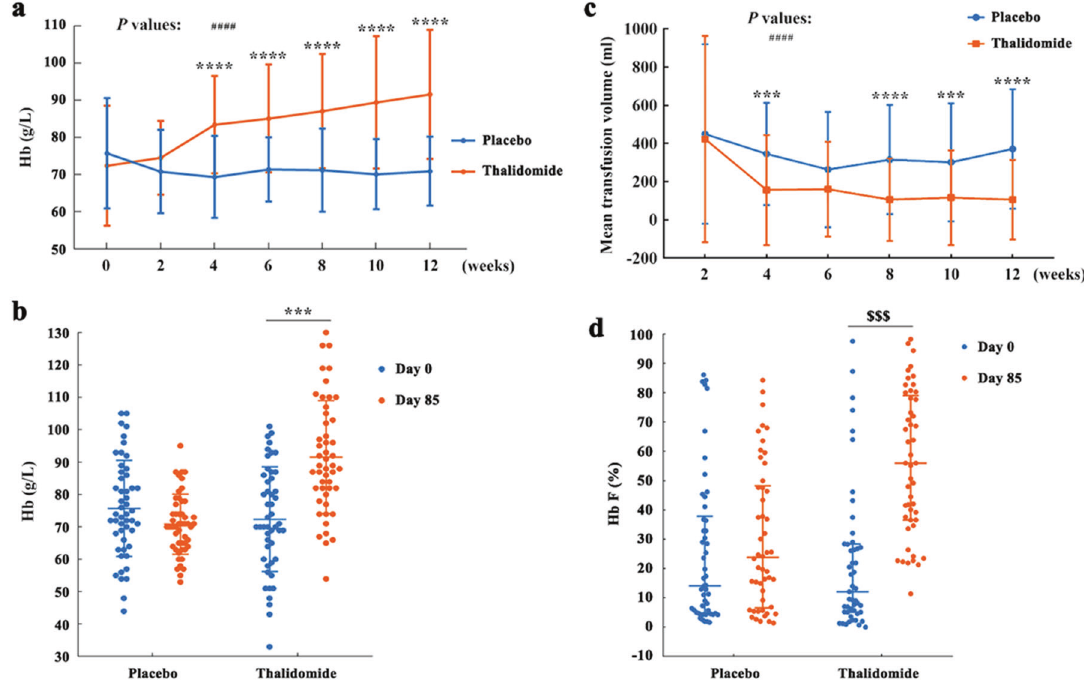
Fig. 2 Changes in Hb, transfusion volume, and Hb F in patients upon placebo or thalidomide treatment. The levels of Hb ( a , b ) and transfusion volume ( c ) were expressed as mean ± standard deviation (SD), and P values determined by Student ’ s t test (*) and mixed-effects regression analyses (#) were provided. *** P < 0.001, **** P < 0.0001; #### P < 0.0001. The percentages of Hb F ( d ) were expressed as median (interquartile range), and P value was determined by Mann – Whitney U test. $$$ P < 0.001 Table 2. Genotype and change in Hb. Data are expressed as median (range) Genotype Table 3. Hb levels of the patients treated with thalidomide at indicated time points